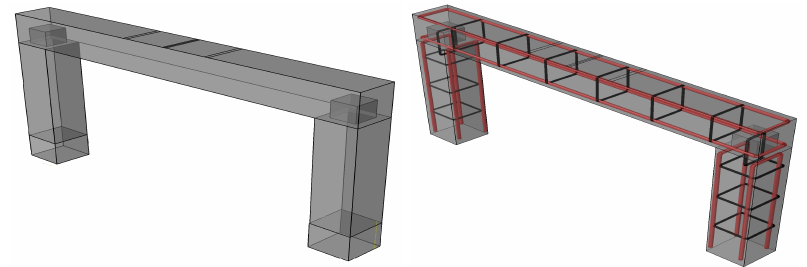
Figure 5. F1, Rebar layout and geometrical dimensions.